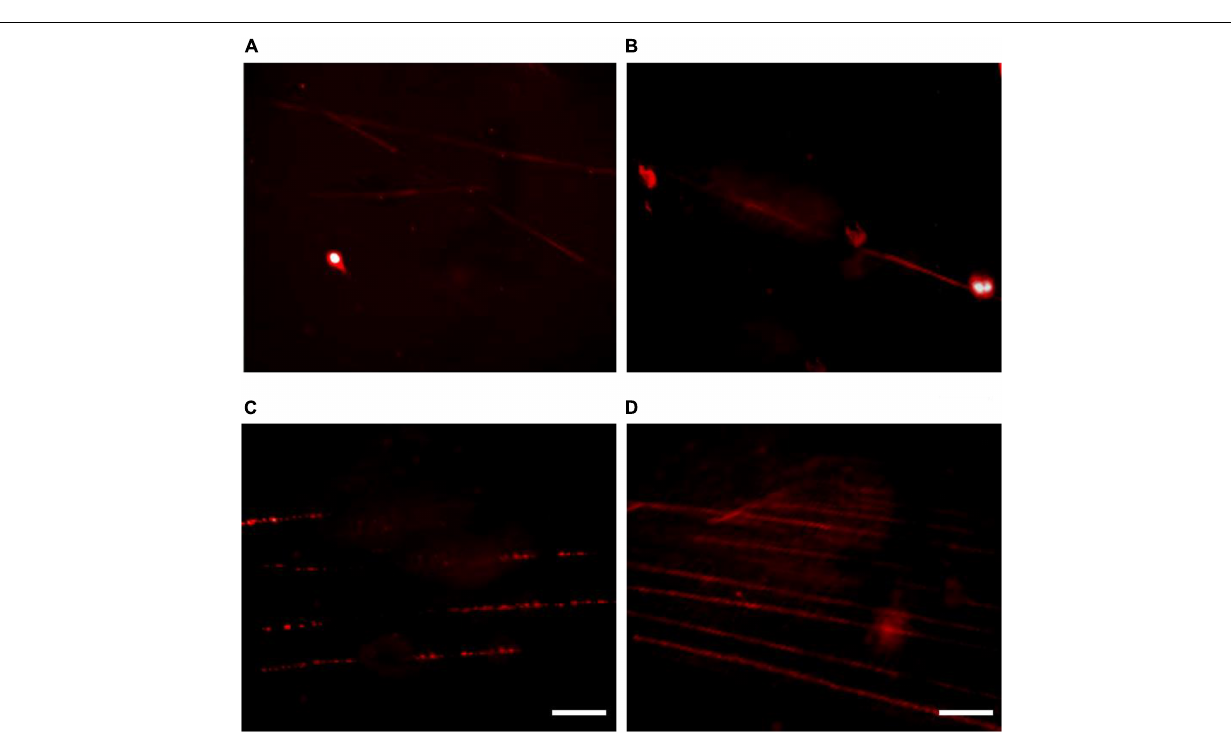
Frontiers in Plant Science |